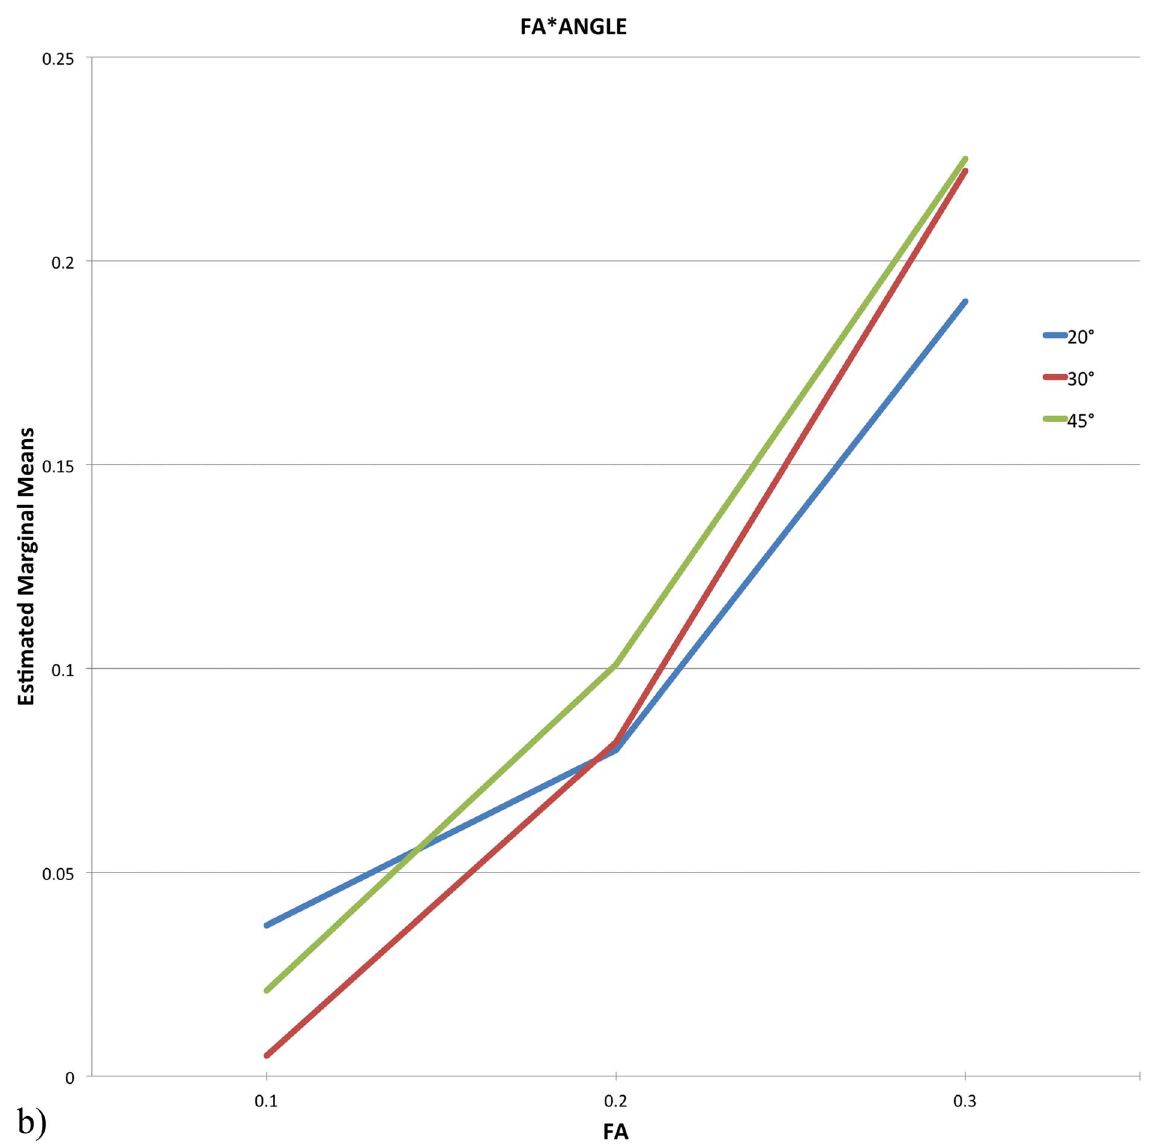
Figure 2. Repeated-measures ANOVA: Interaction graphs for FA*ANGLE. The interaction graph, similar to Figure 1, but in the opposite way, again illustrates the crucial influence of the FA